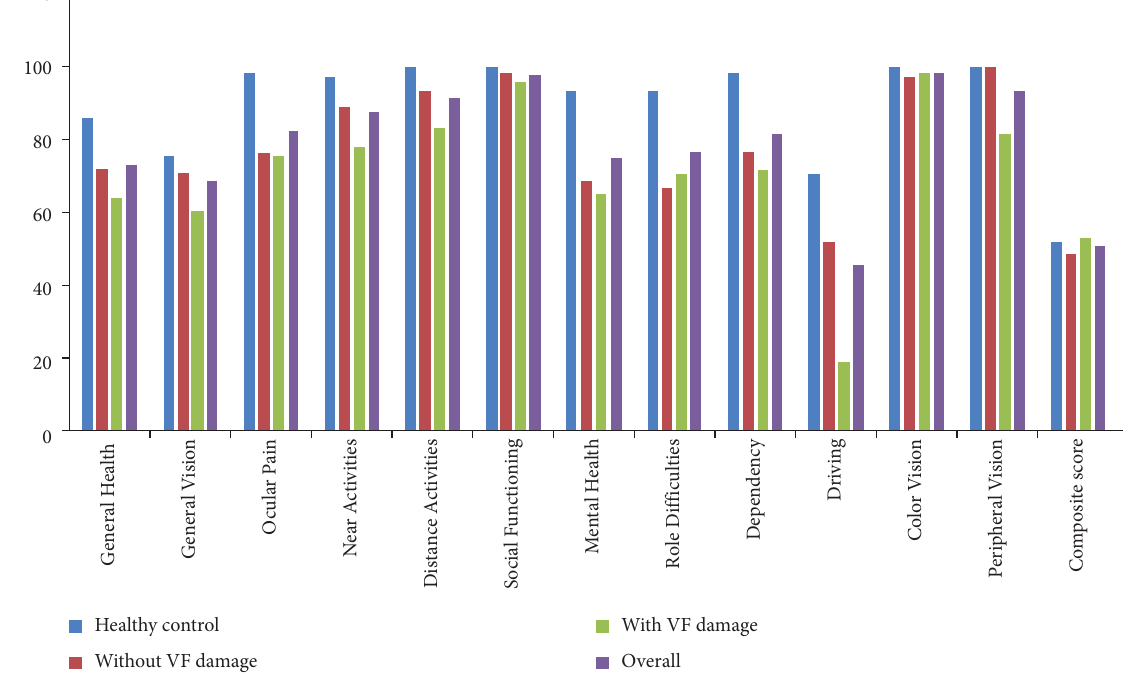
Figure 1: Te overall average scores of the NEI